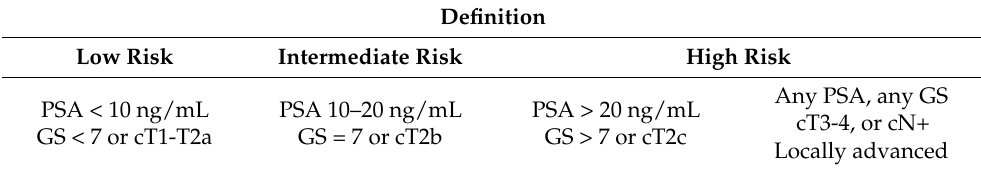
Table 1. EAU risk groups for biochemical recurrence of localized and locally advanced